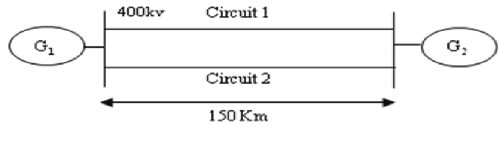
Fig.1. Power system under study